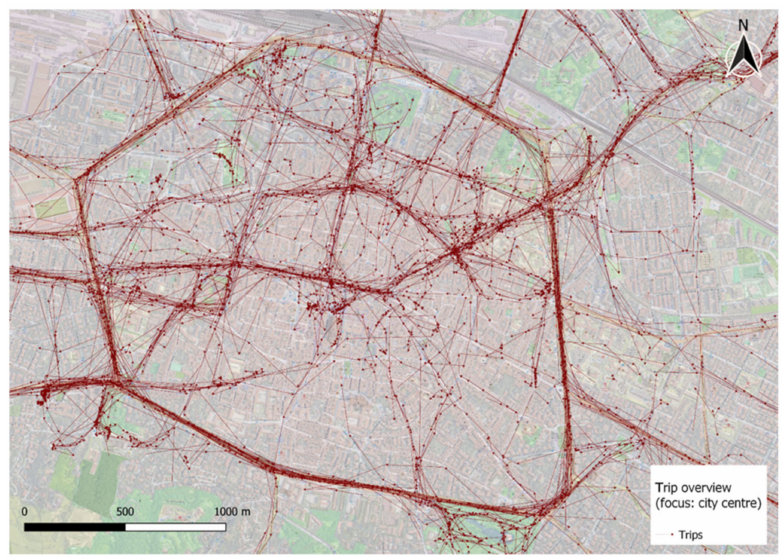
Figure 6. Trip distribution overview in city center (applied threshold: “day” and